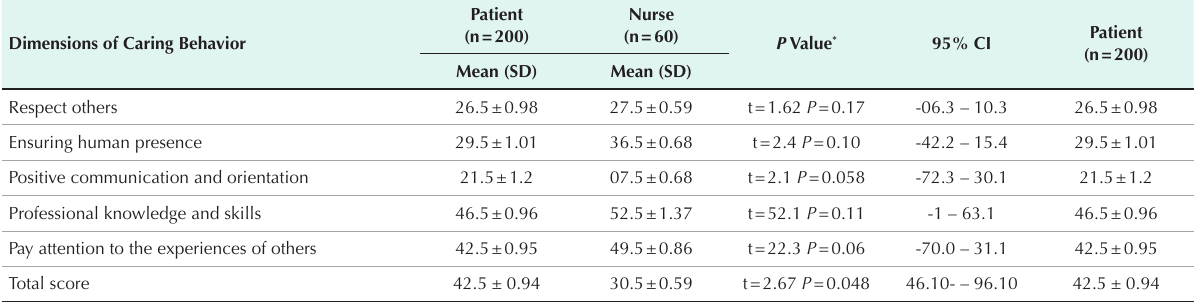
Table 3. Comparison of the Mean and SD of the Sub-scales and Total Caring Behaviors of Nursing Staff From the Patients and Nurses’ Views in Imam Khomeini Hospital in Khalkhal